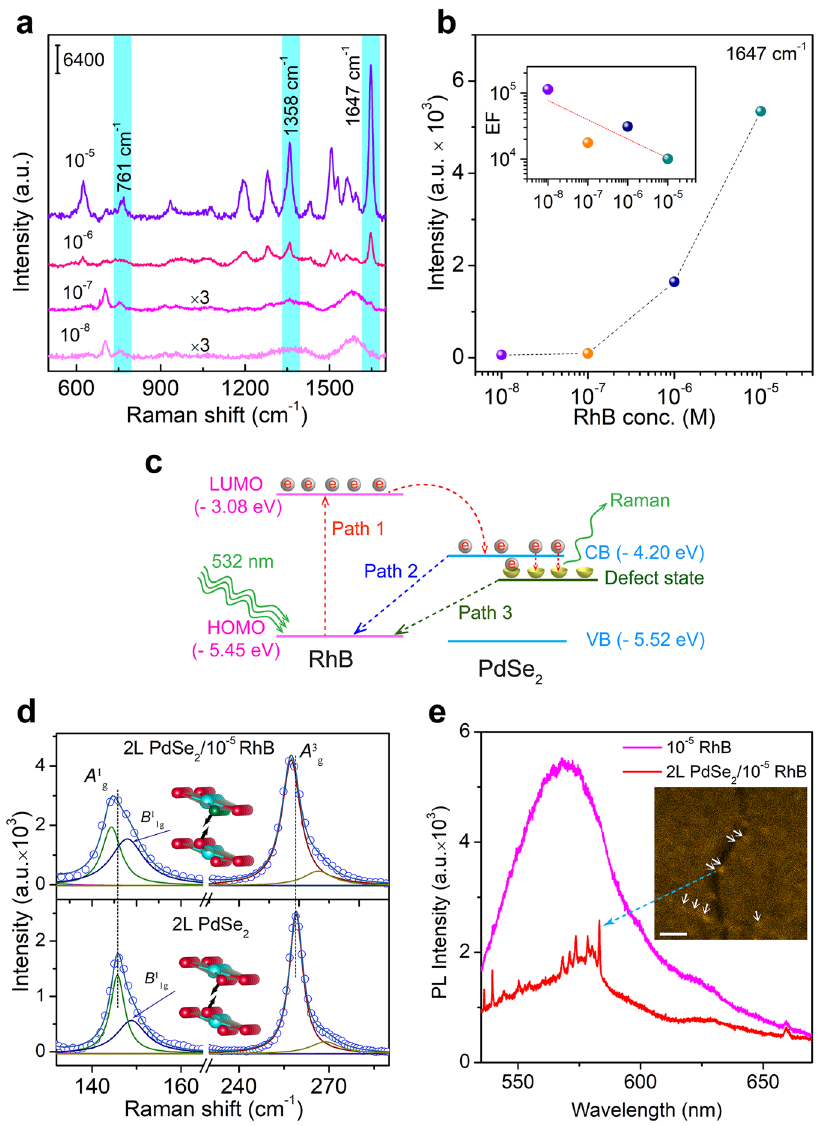
Fig. 6 SERS enhancement factor and its mechanism. a Raman spectra of 10 − 5 M, 10 − 6 , 10 − 7 , 10 − 8 M RhB on PdSe 2 , b the corresponding intensity semi-log plot for C – C bending and C = C stretching as a function of RhB concentration. The inset shows the log plot of calculated enhancement factor (EF). c Energy band diagram showing the charge transfer pathways in RhB/PdSe 2 hybrid system. d Stacked Raman spectra of 2L PdSe 2 and 10 − 5 RhB drop-casted 2L PdSe 2 , where the inset atomic models show the B 1 photoluminescence spectra of 10 − 5 M RhB on mica substrate and SERS spectrum of 2L PdSe 2 /10 − 5 RhB. The inset shows the confocal microscopy image of RbB molecules on the defective sites (scale bar: 5 μ